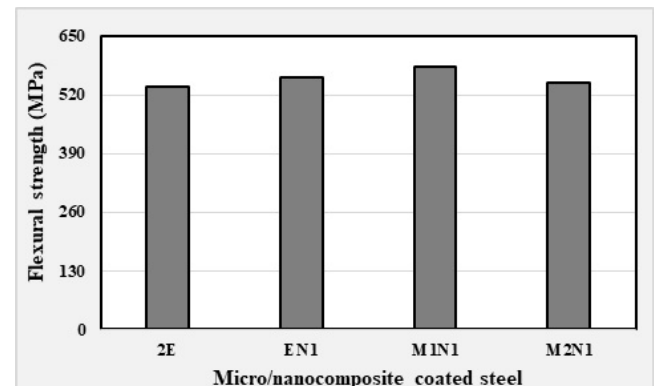
O micro/nanoparticles. 2 3